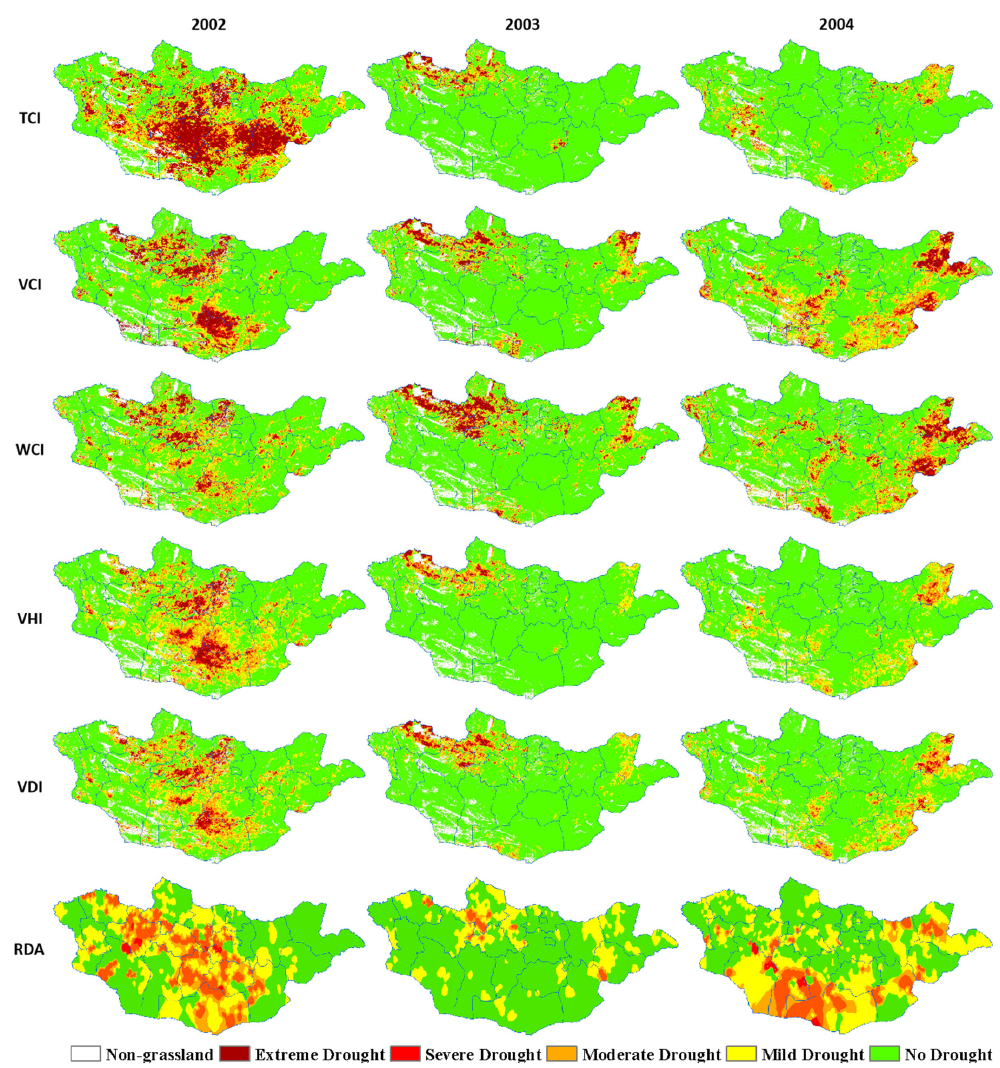
Figure 3. Drought distribution maps for the TCI, VCI, WCI, VHI, VDI, and field-based RDA in the first dekad of each July from 2002 to 2004 for Mongolia.